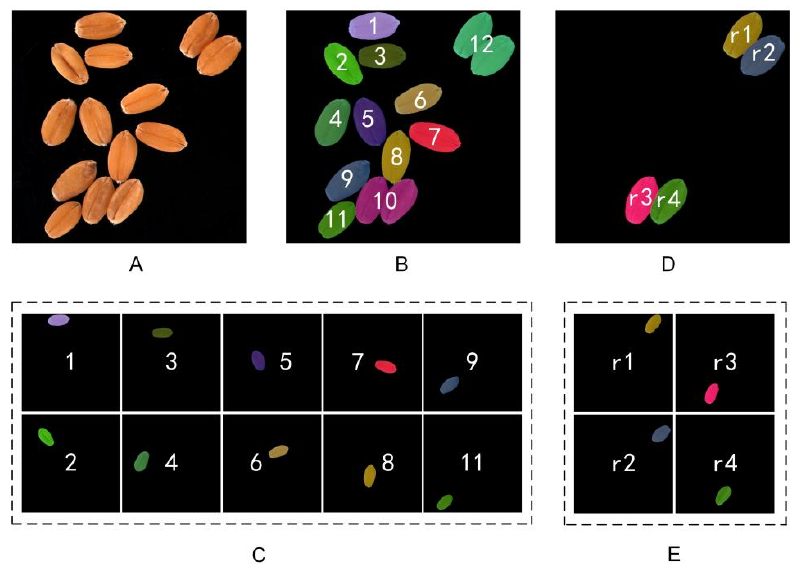
Figure 5. An example of under-segmentation using MWS and our improved method. ( A ) represents a raw image; ( B ) represents the segmented image; ( C ) represents the correctly segmented images; ( D ) represents the resegmented image; ( E ) represents the correctly resegmented images.